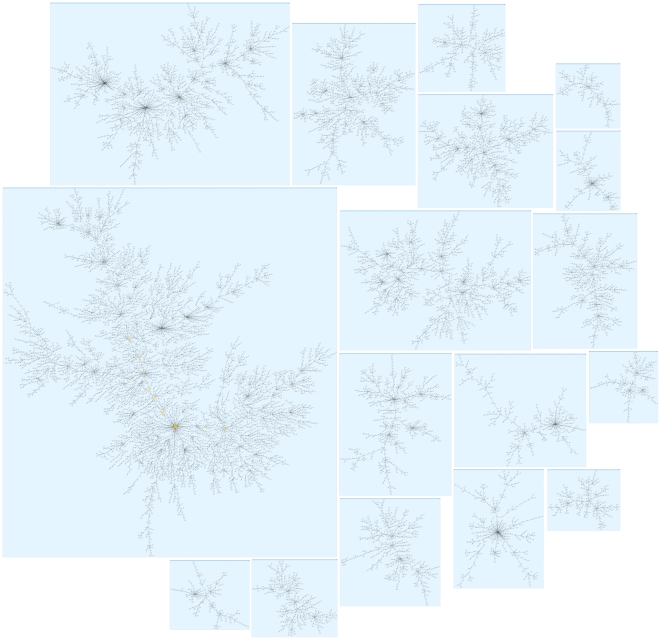
The seventeen largest clusters.The clustering results from using a distance measure based on changes in correlation of gene expression between classes.